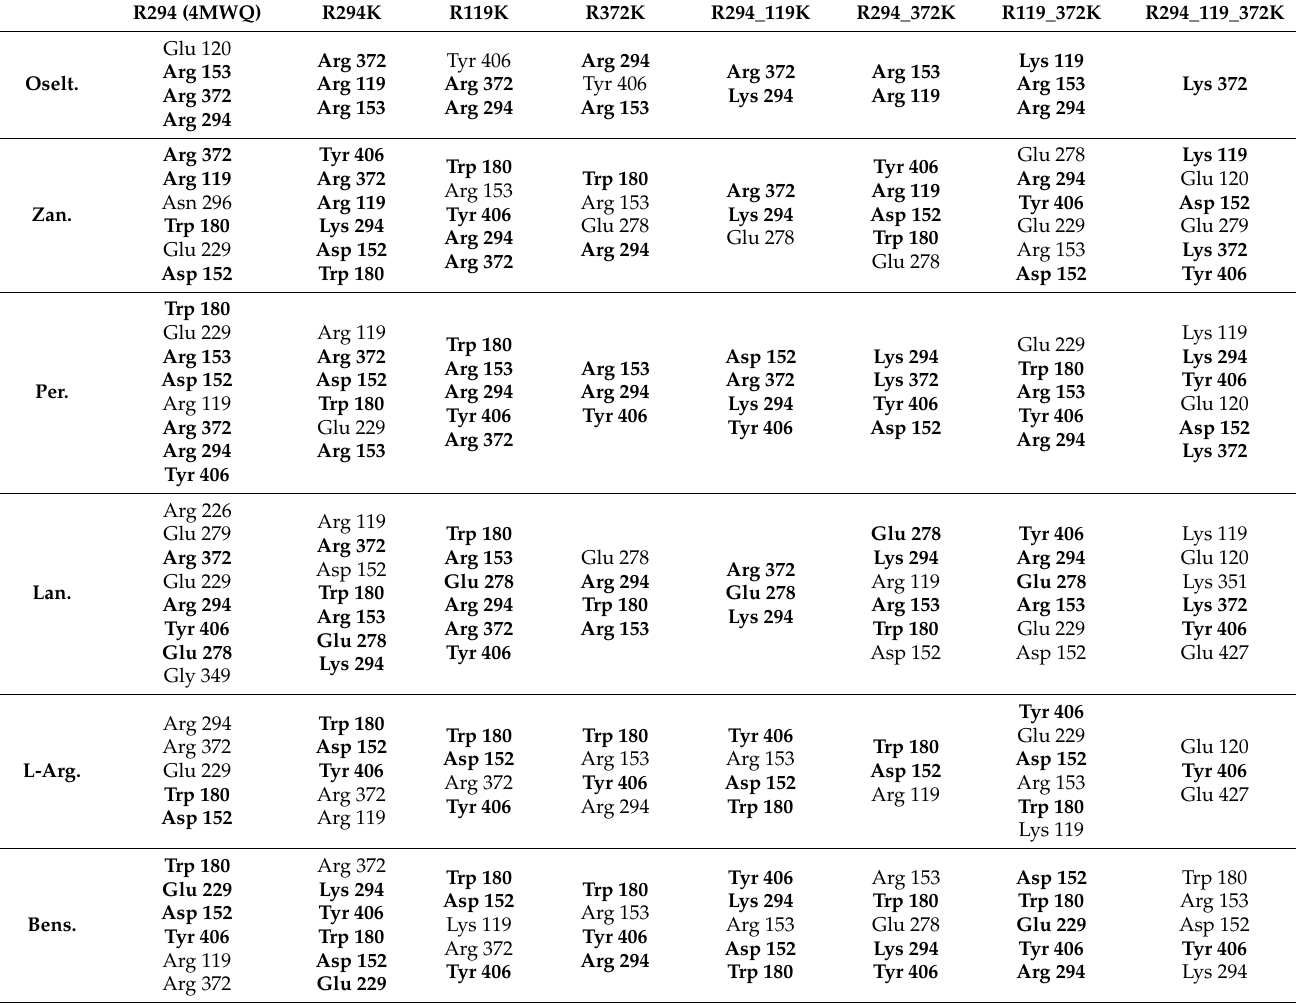
Table 4. H- bond interaction profile for all the drugs compared 1